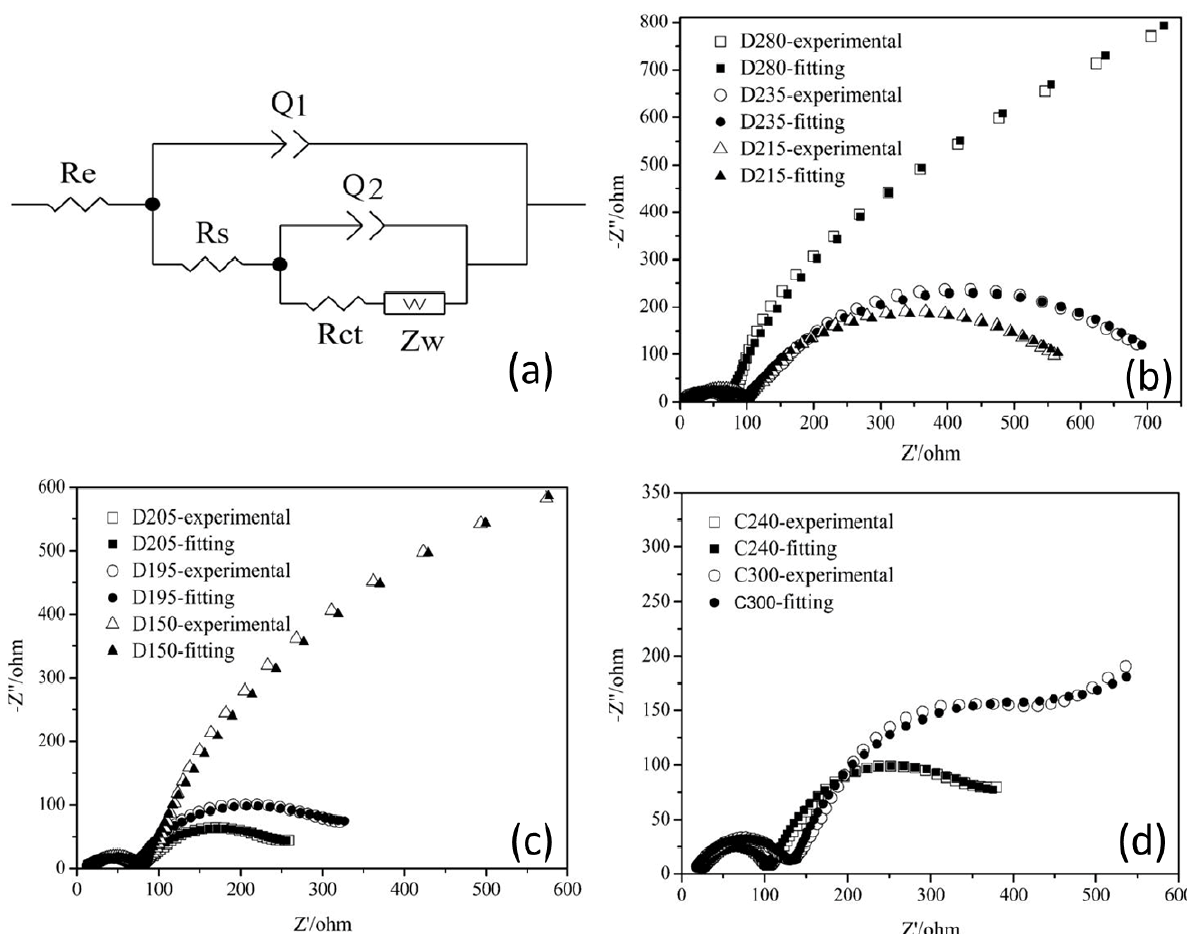
Figure 7. EIS of AB/S-4 electrodes. ( a ) Equivalent circuit used in fitting the data; ( b ) Nyquist plots for 2.80 V (D280), 2.35 V (D235) and 2.15 V (D215) for initial discharge; ( c ) Nyquist plots for 2.05 V (D205), 1.95 V (D195) and 1.50 V (D150) for initial discharge; ( d ) Nyquist plots for 2.40 V (C240) and 3.00 V (C300) for initial